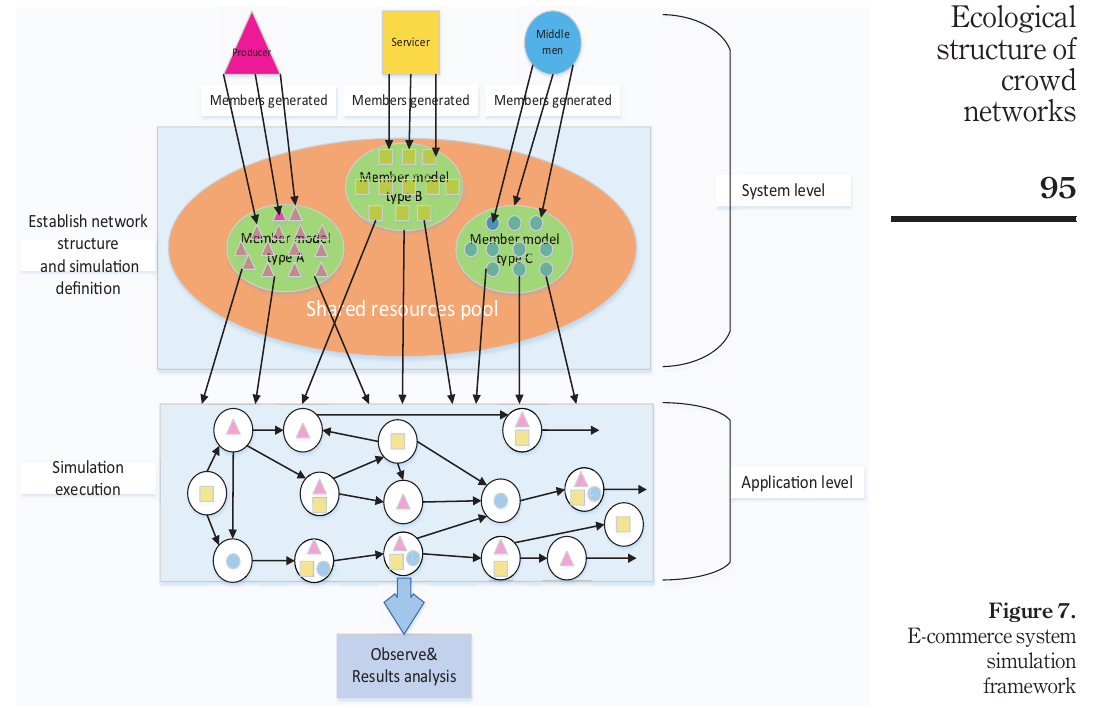
algorithm 1 . Generate_pattern(NUM, beginnode, endnode)